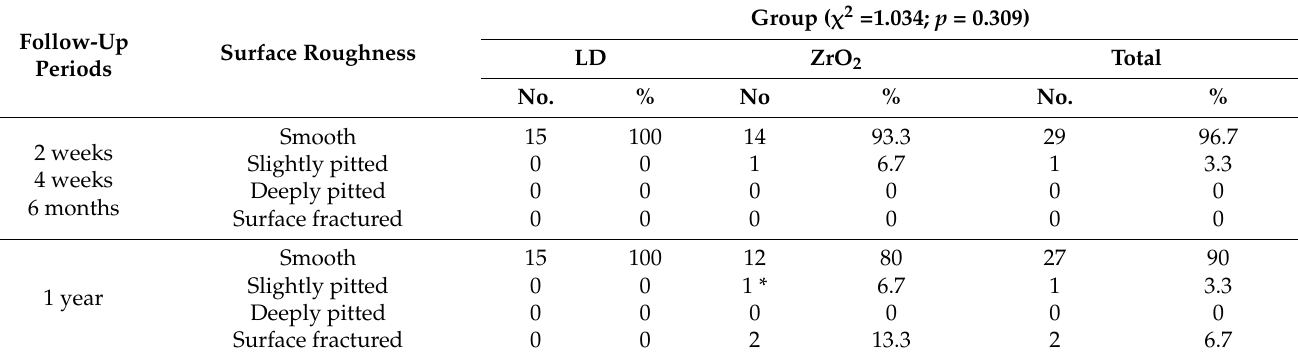
Table 8. The surface roughness in the study